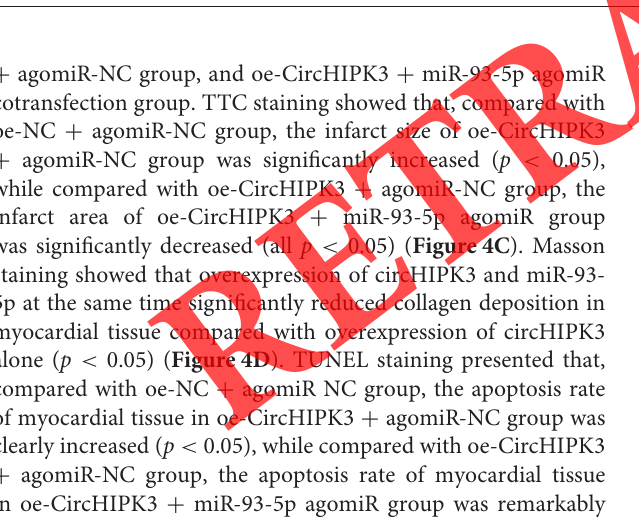
FIGURE 3 | CircHIPK3 sponges miR-93-5p as a ceRNA. (A) RNA-FISH was used to detect the subcellular localization of CircHIPK3. (B) Bioinformatic website predicted the binding relationship between CircHIPK3 and miR-93-5p. (C) Dual-luciferase reporter gene assay was used to verify the binding relationship between CircHIPK3 and miR-93-5p. (D) RIP assay was used to detect the relationship between CircHIPK3 and Ago2. (E) RNA pull-down test was used to verify the binding of CircHIPK3 and miR-93-5p. The value in the figures is the measurement data, which is expressed as mean ± standard deviation. The comparison between two groups was analyzed by independent-sample t -test. The comparison among multiple groups was analyzed by one-way ANOVA, followed by Tukey’s multiple-comparisons test, * p < 0.05. The experiment was repeated three times.